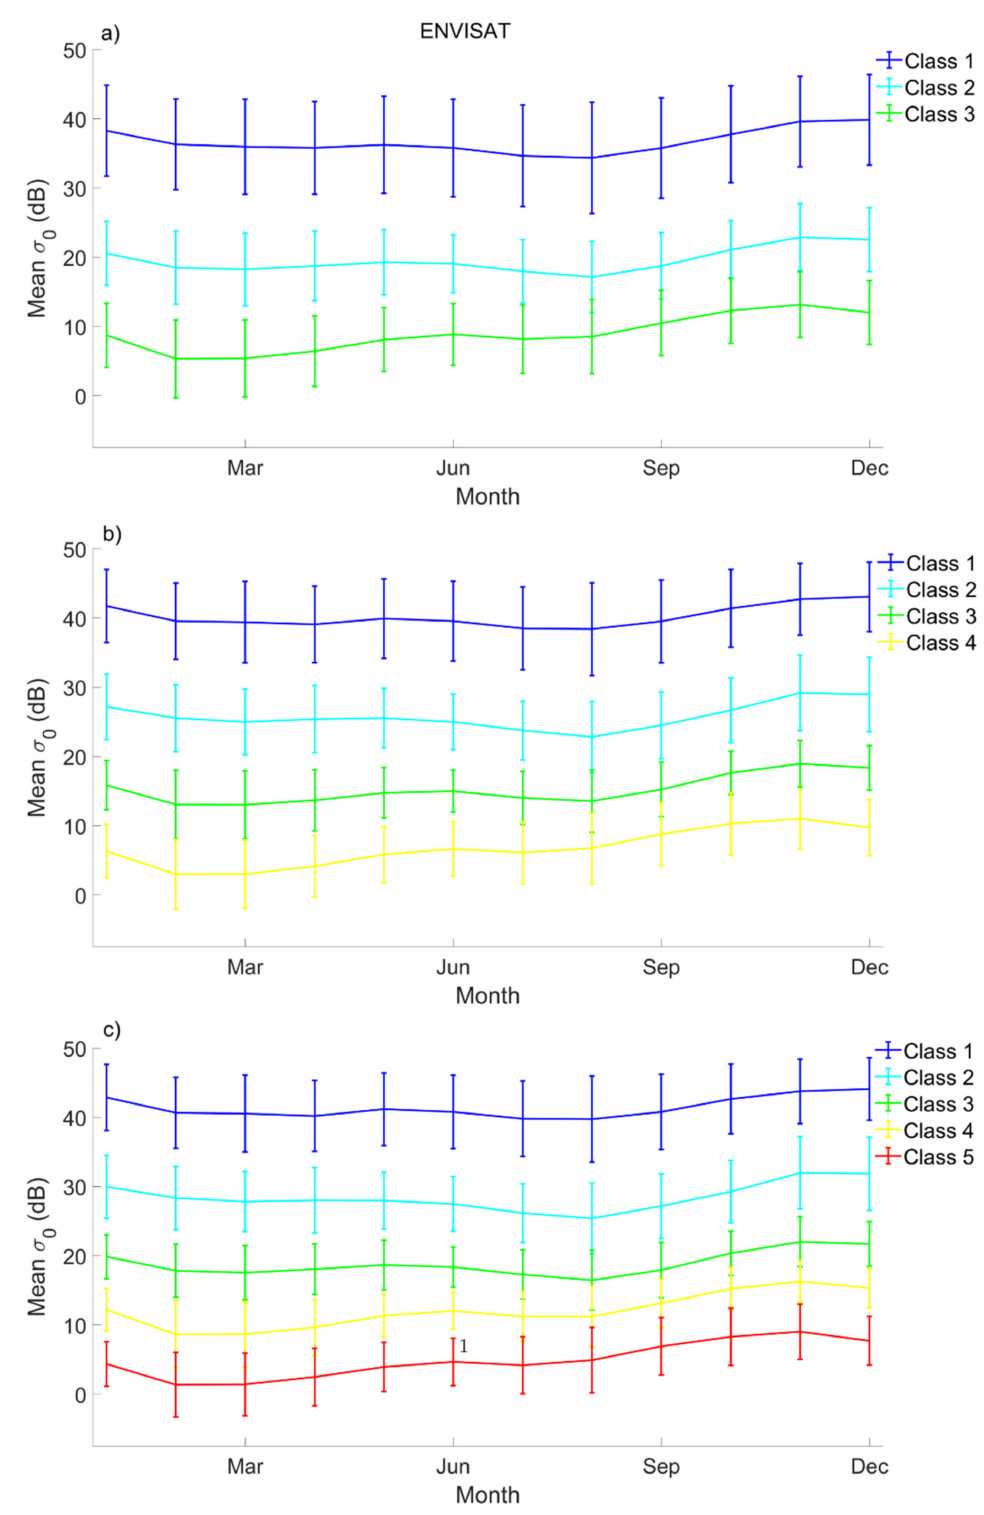
Figure 3. Seasonal variations in the mean backscattering coefficient and its associated deviation at Ku-band from ENVISAT (2003–2010) for each class when considering ( a ) 3, ( b ) 4, ( c ) 5